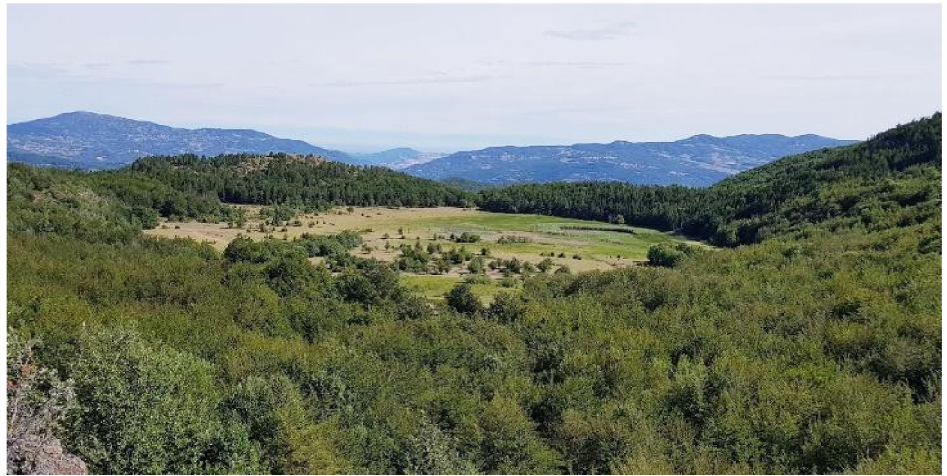
Figure 4. Panoramic view of the Lake Moo basin from the